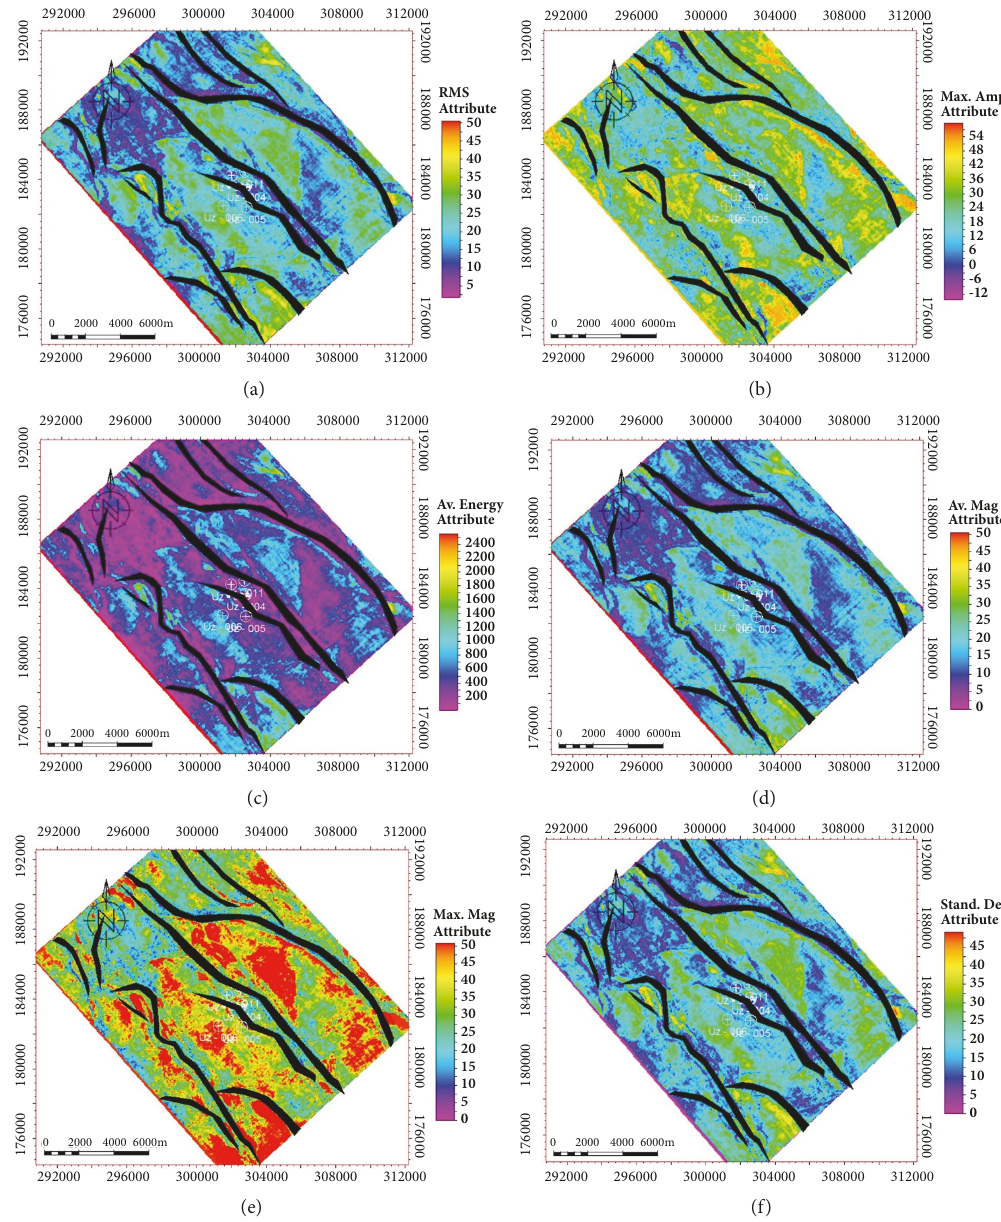
Figure8:GeneratedamplitudemapsD5000reservoirtop.(a)RMSamplitudeAttributemapforD5000reservoirtop.(b)Maximumamplitude attribute map for D5000 reservoir top. (c) Average energy amplitude attributes for D5000 reservoir top. (d) Average magnitude amplitude attributesfor D5000reservoir top. (e) Maximummagnitude attributemap for D5000reservoir top. (f) Standard deviation amplitude attribute map for D5000 reservoir